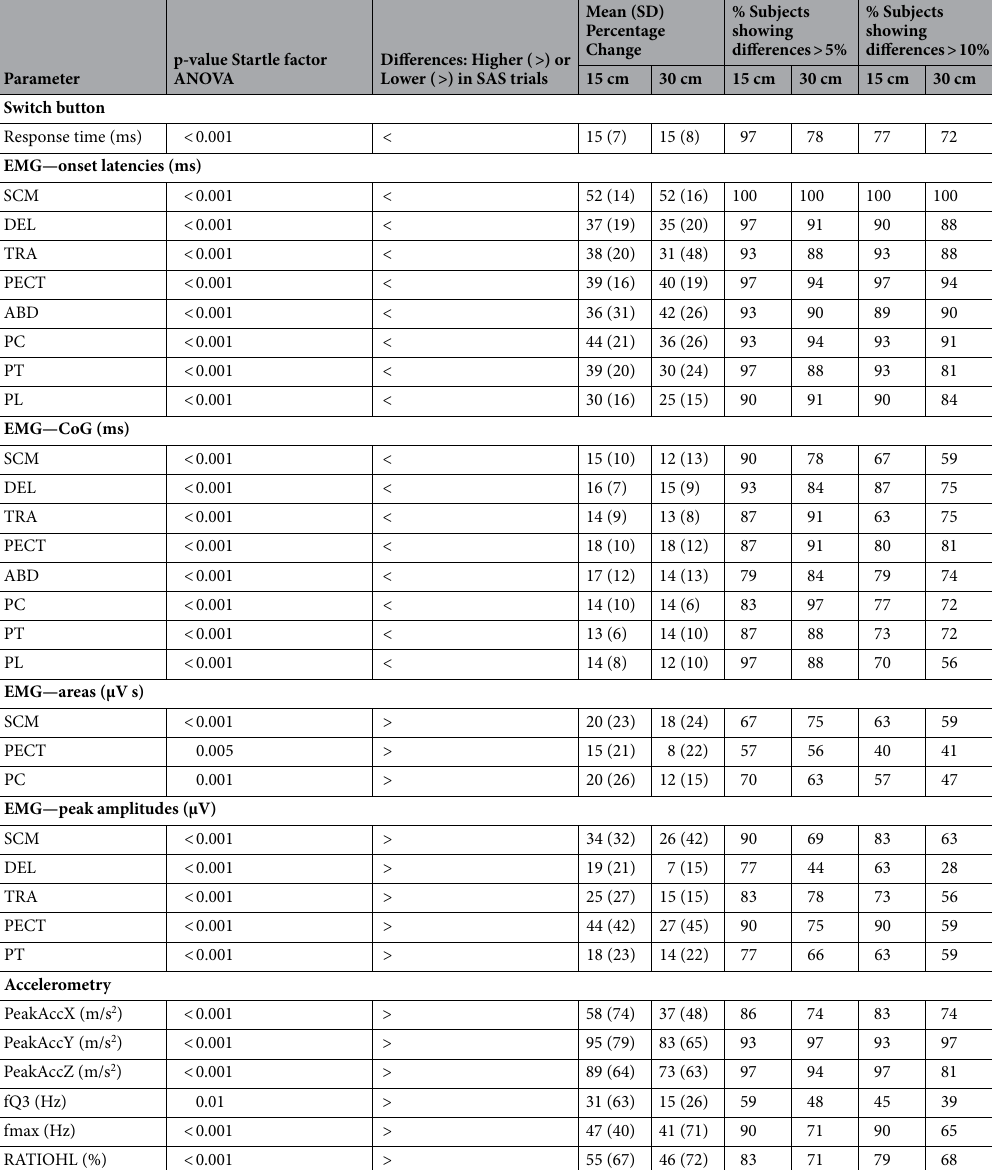
SAS and SAS trials, at 15 cm and 30